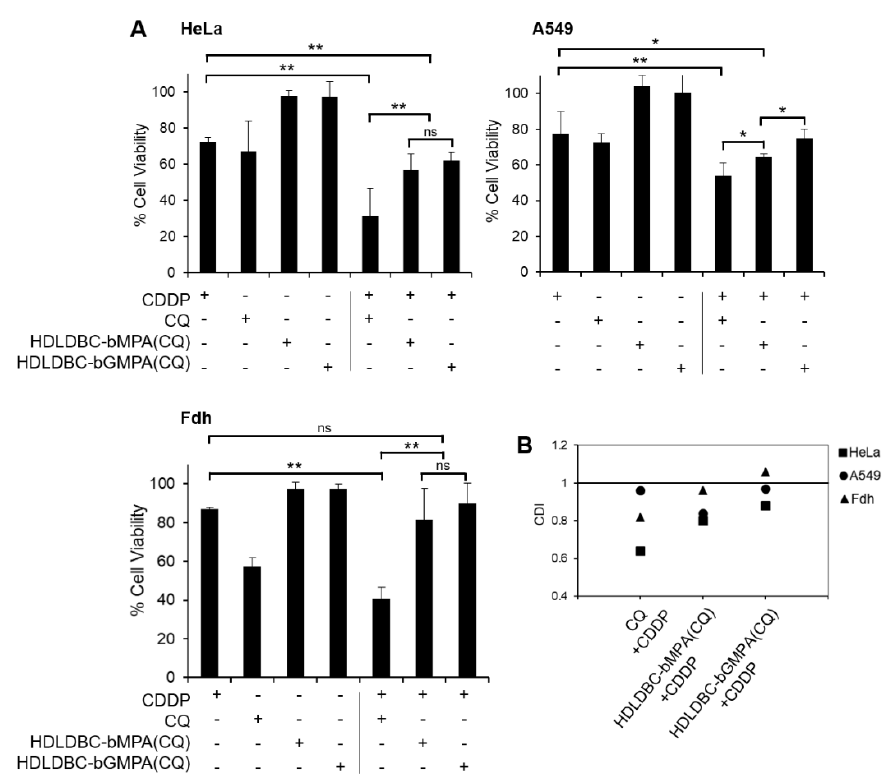
Figure 7. Effect of pre-treatment with 40 µ M of free CQ, HDLDBC-bMPA(CQ) or HDLDBC- bGMPA(CQ) in the treatment with free CDDP in HeLa and A549 cells and fibroblasts (Fdh). ( A ) Cell viability after single treatment with 40 µ M of CQ or 1 µ g/mL of CDDP (left side) or combined treatment (right side) (** p < 0.01 and * p < 0.05; ns: not significant). ( B ) The CDI value represents a measure of the degree of interaction between two drugs. When this value is between 0.7 and 1, it indicates a low–moderate synergism; when CDI is between 0.3 and 0.7, it indicates a high synergism.